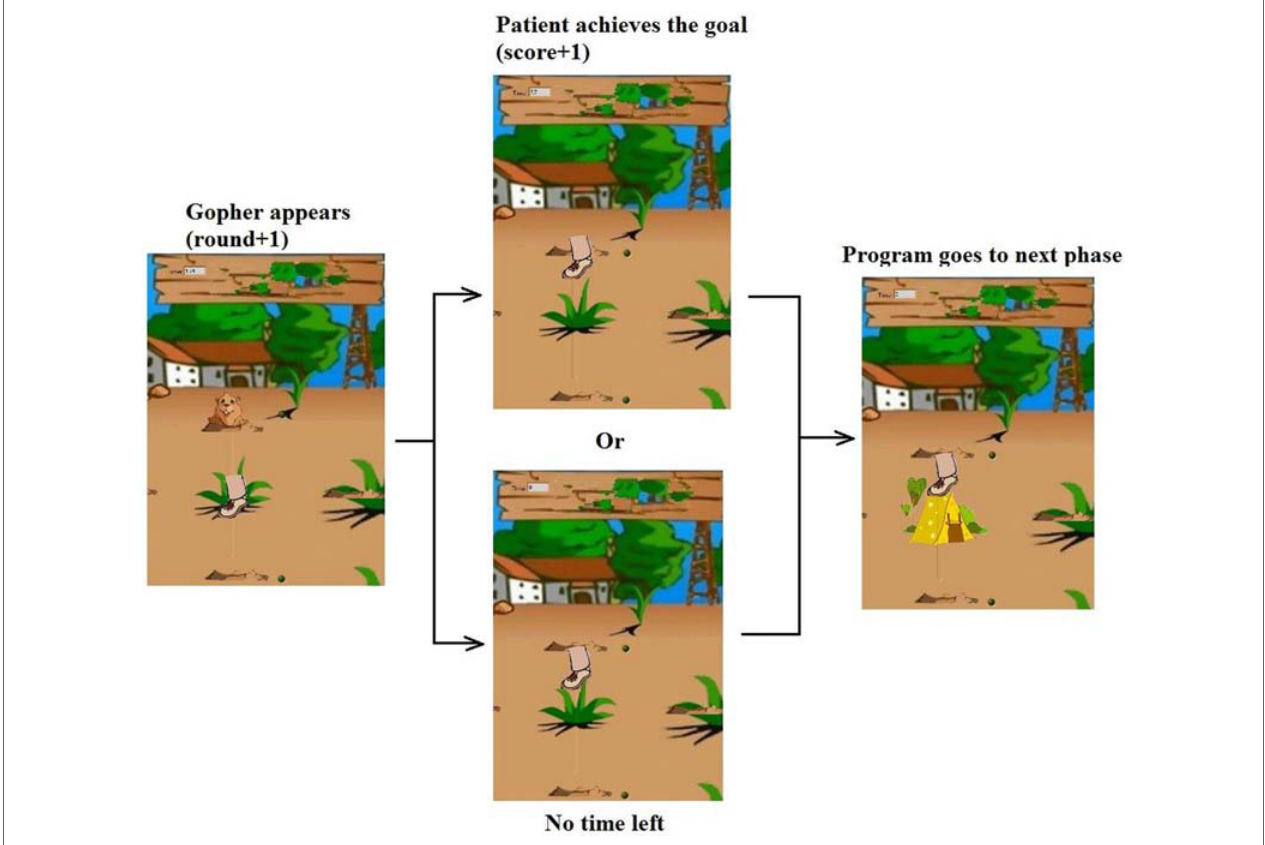
FIGURE 10 | The virtual reality game designed to guide the patient perform target reach